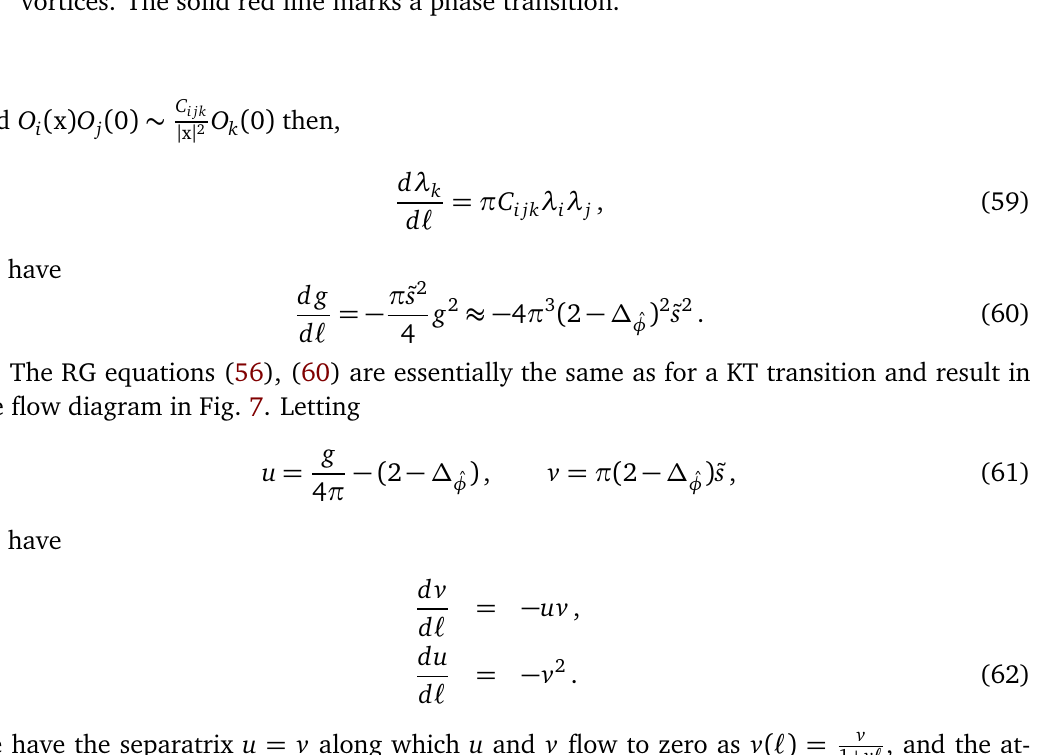
Figure 7: RG flow at the boundary of 2 + 1D Bose-Hubbard model in the absence of vortices. The solid red line marks a phase